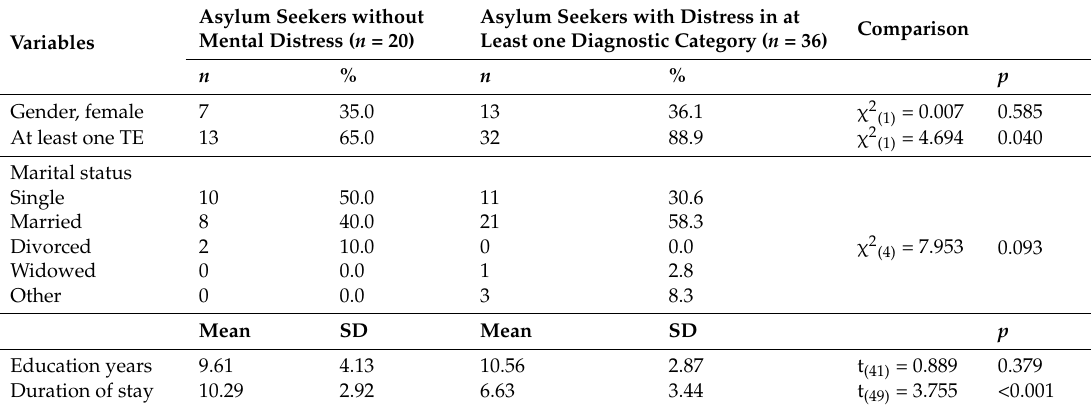
Table 5. Comparison between asylum seekers without mental distress and asylum seekers with distress in at least one diagnostic